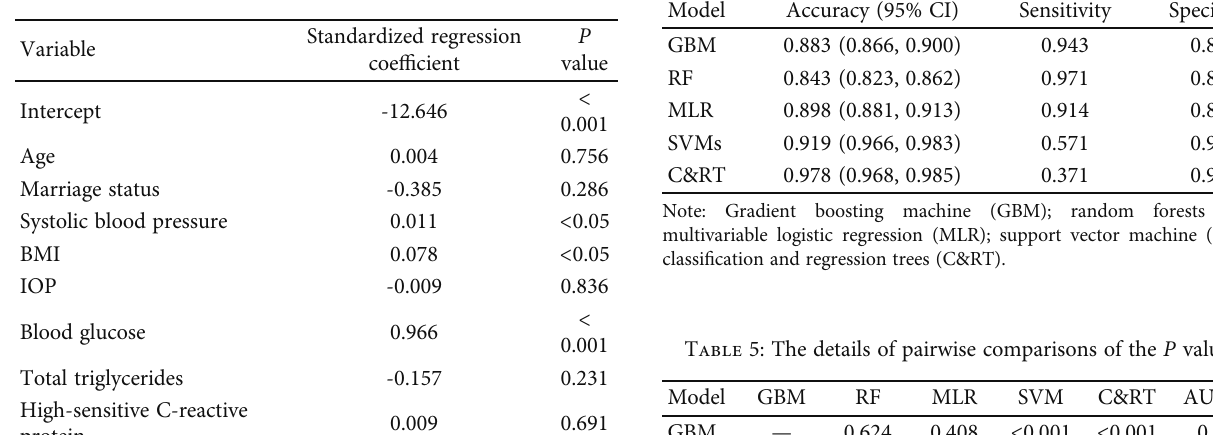
Table 3: Model performance using multivariable logistic regression model ( n = 4572 ).